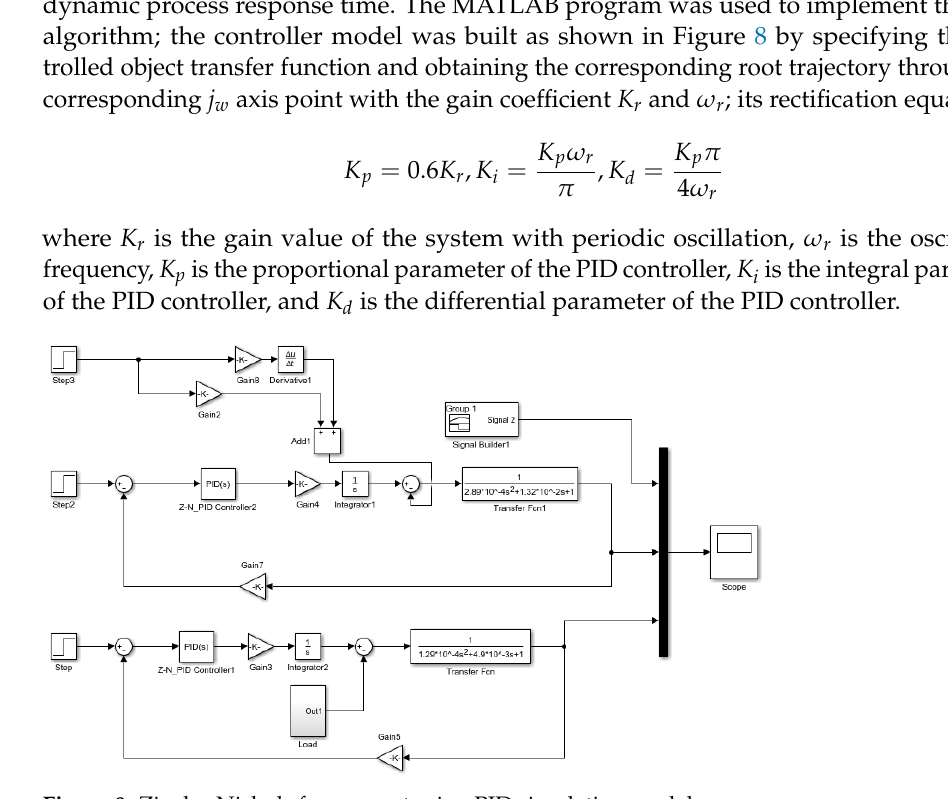
Figure 8. Ziegler-Nichols frequency tuning PID simulation model.